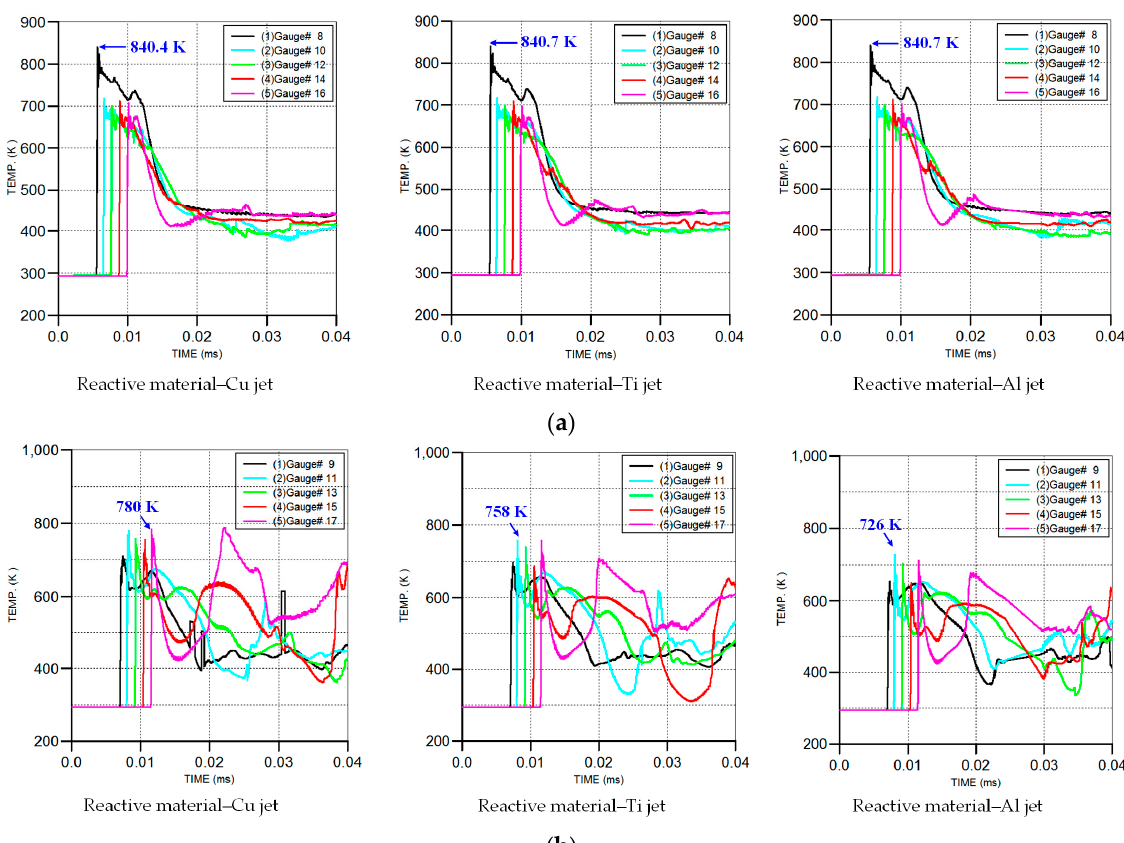
Figure 13. Temperature distribution of the reactive material slug under different composite jets: ( a ) reactive material–Cu jet; ( b ) reactive material–Ti jet; ( c ) reactive material–Al jet.